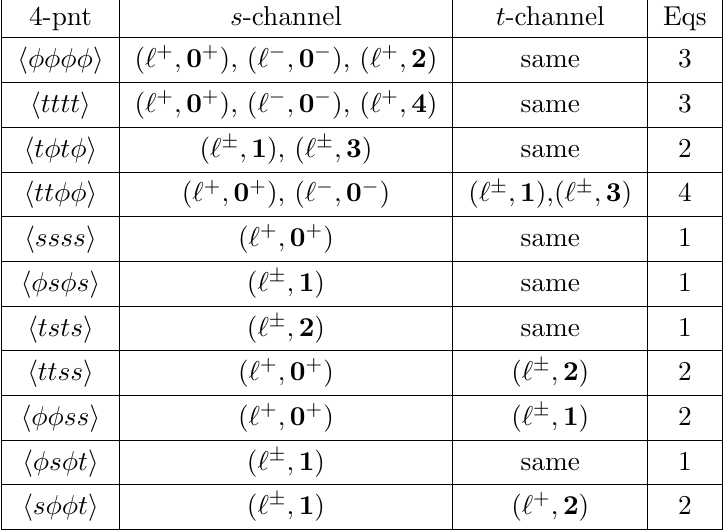
Table 2 . Four-point function con(cid:12)gurations that give independent crossing equations under equat- ing their s - and t -channel, along with the even/odd spins that appear for each irrep in each channel, and the number of crossing equations that each con(cid:12)guration